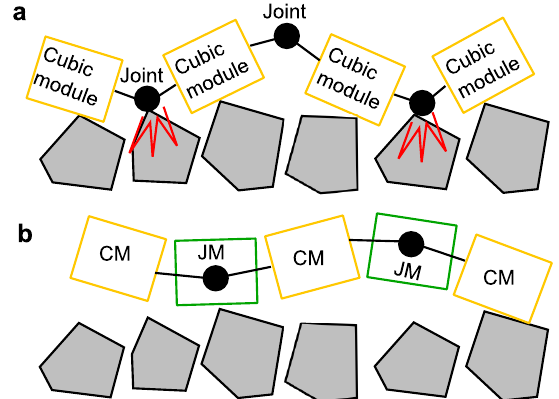
Fig. 3 The difference between the WORMESH-I and WORMESH-II concepts. a WORMESH-I is composed of Cubic modules that are joined to one another via a joint mechanism. Because of this connection, the joint mechanism can make direct touch with the ground. b This issue was fixed in WORMESH-II by substituting a joint module for the joint mechanism that was used in WORMESH-I